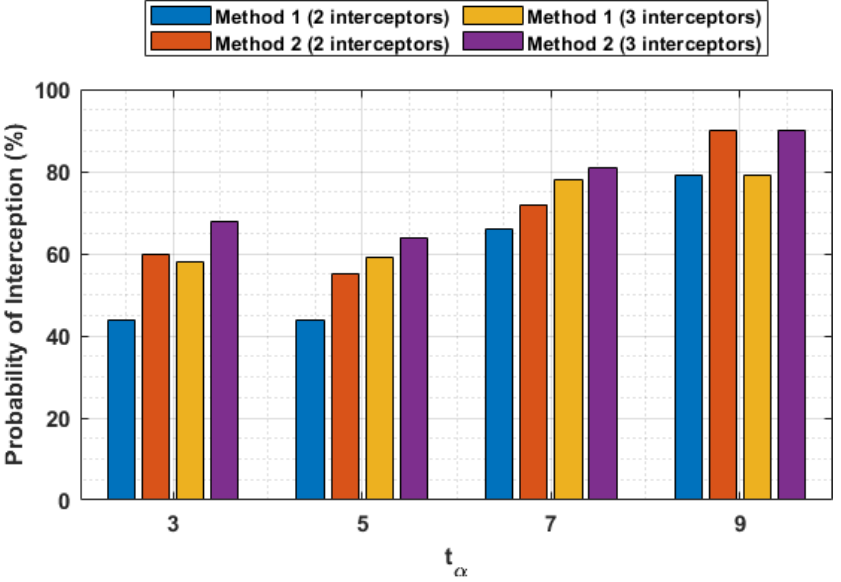
Figure 11. Comparison of the probability of interception for all t α , in Case 1.